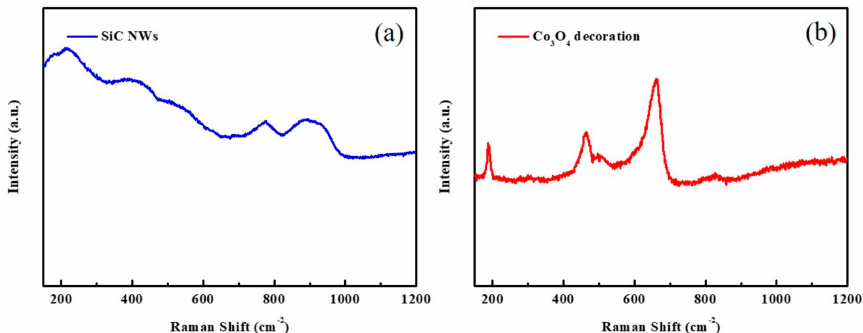
Figure 2. Raman spectra of ( a ) SiC NW film, and ( b ) Co 3 O 4 /SiC NTA